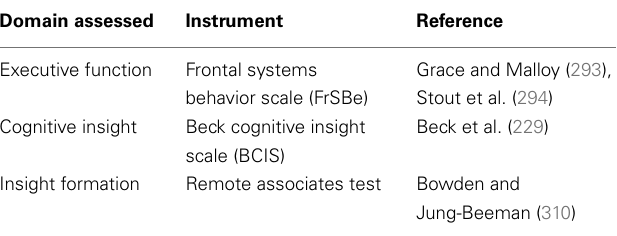
Table 12 | Instruments recommended for cognitive